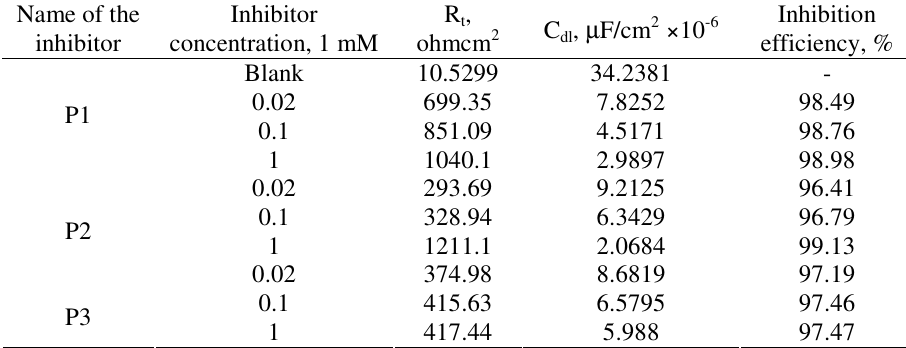
SO solution with different 2 4